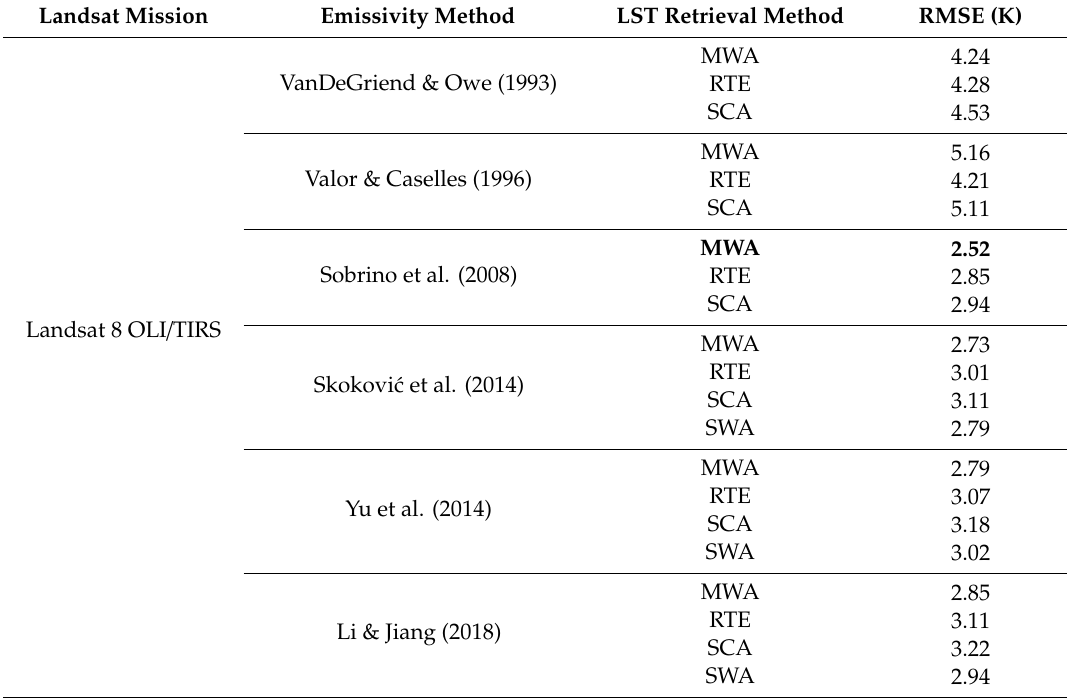
Table 7. Validation results of LST retrieval methods for Landsat 8 OLI / TIRS data based on di ff erent LSE models. The best result is in